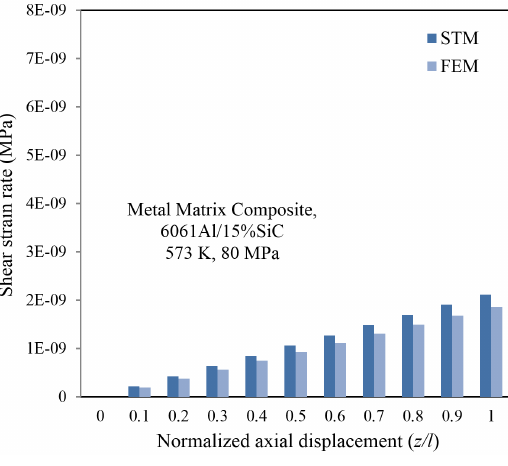
Figure 8. Shear strain rate behavior at r = a - δ . Table 1. Comparison between the obtained results and experimental data 2 for obtaining the radial displacement rate at the outer surface (  b u ).